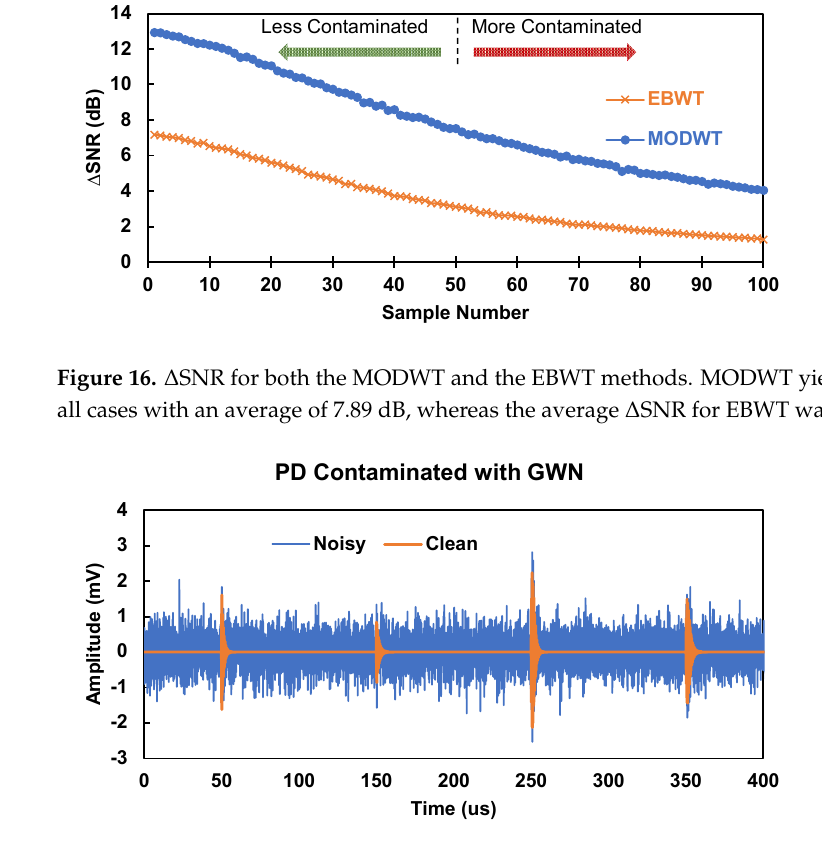
Figure 17. Simulated PD signal contaminated with GWN. SNR = − 10.12 dB and NCC = 0.28.